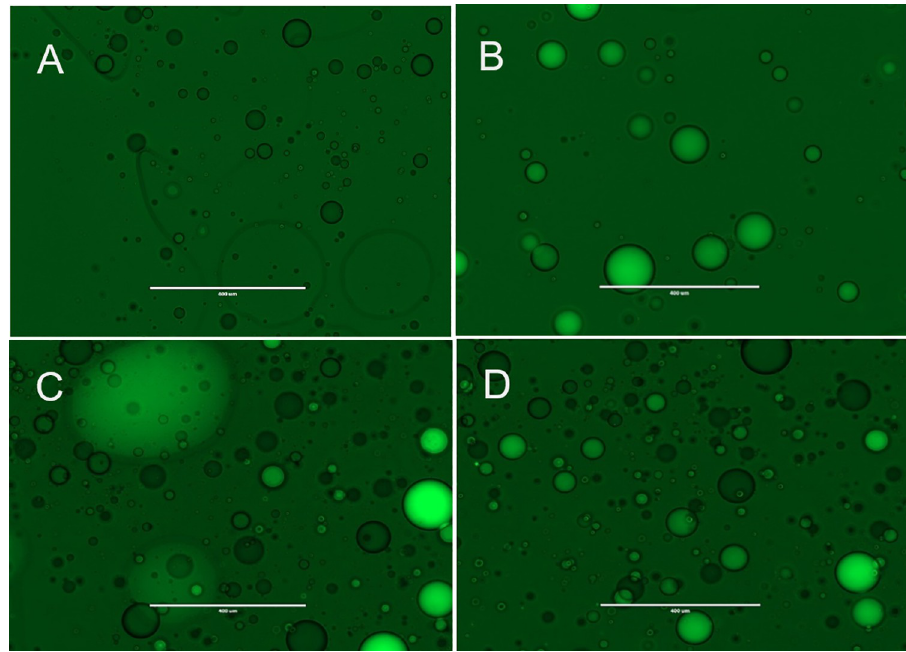
Fig 9. Transmission microscope images of droplets containing oligos with a FAM fluorescent molecule or a Black Hole Quencher (BHQ). The fluorinated fluid (fluid B) with 1% of surfactant (b-R 1 ) was pumped at 10 μ L/min. Aqueous phase contained 5 μ M of 5’-CTGCTCATAGG CAGTCCGTCA-BHQ-3’ or 5’- FAM-TGACGGACTGCCTATGAGCAG-3’ in 20 mM Tris-HCl, pH 8.4; 10 mM (NH 4 ) 2 SO 4 ; 10 mM KCl; 2 mM MgSO 4 ; 0.1% Triton 1 X-100. Aqueous phase was pumped at 2 μ L/min. (A) Droplets carrying oligo with Black Hole Quencher (BHQ). (B) Droplets carrying oligo with FAM. (C). Droplets carrying BHQ placed on the left side of the glass slide and droplets carrying FAM placed on the right hand side of the slide. (D) After being in contact for 10 minutes no fusion is observed. Scale bar is 400 μ m. Pictures are representative of several trials.